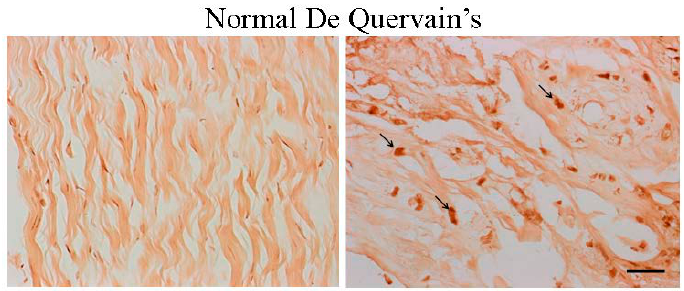
Figure 1. Compared with the samples from healthy controls, estrogen receptor (ER)- β -positive cells were visible in the nuclei of retinacular cells (arrows) in tissue samples from the representative slides of patients with grade II de Quervain’s disease (immunohistochemical staining, 400× magnification, scale bar = 10 μ m).